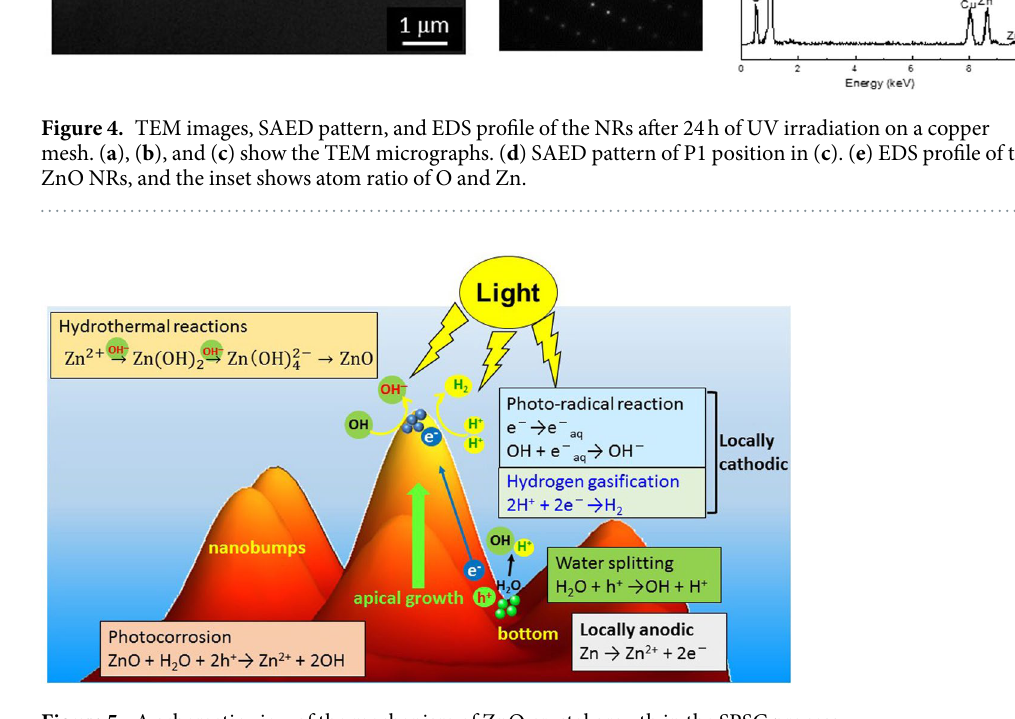
Figure 5. A schematic view of the mechanism of ZnO crystal growth in the SPSC